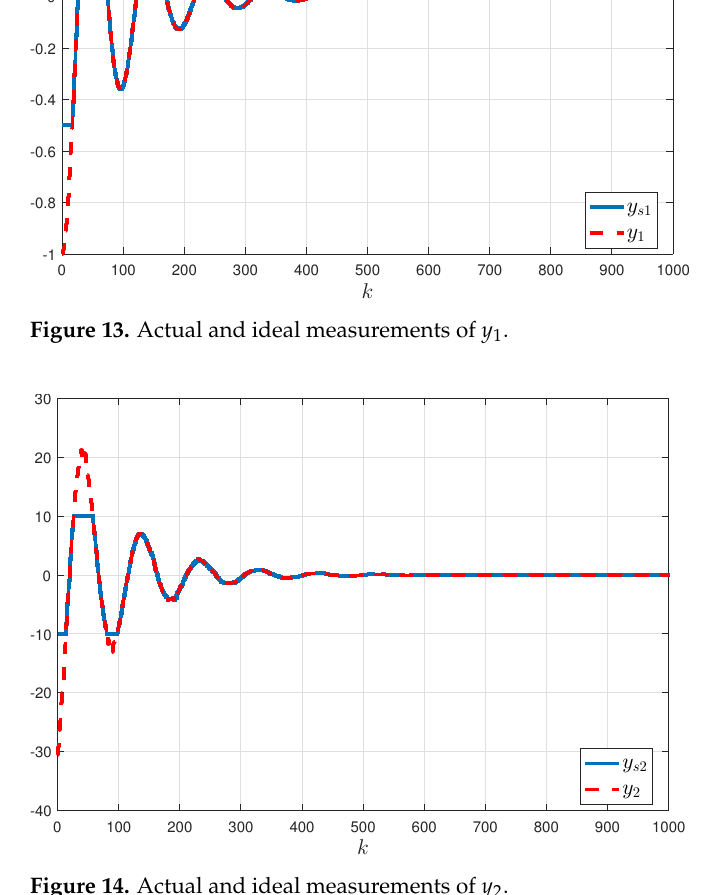
Figure 14. Actual and ideal measurements of y 2 .